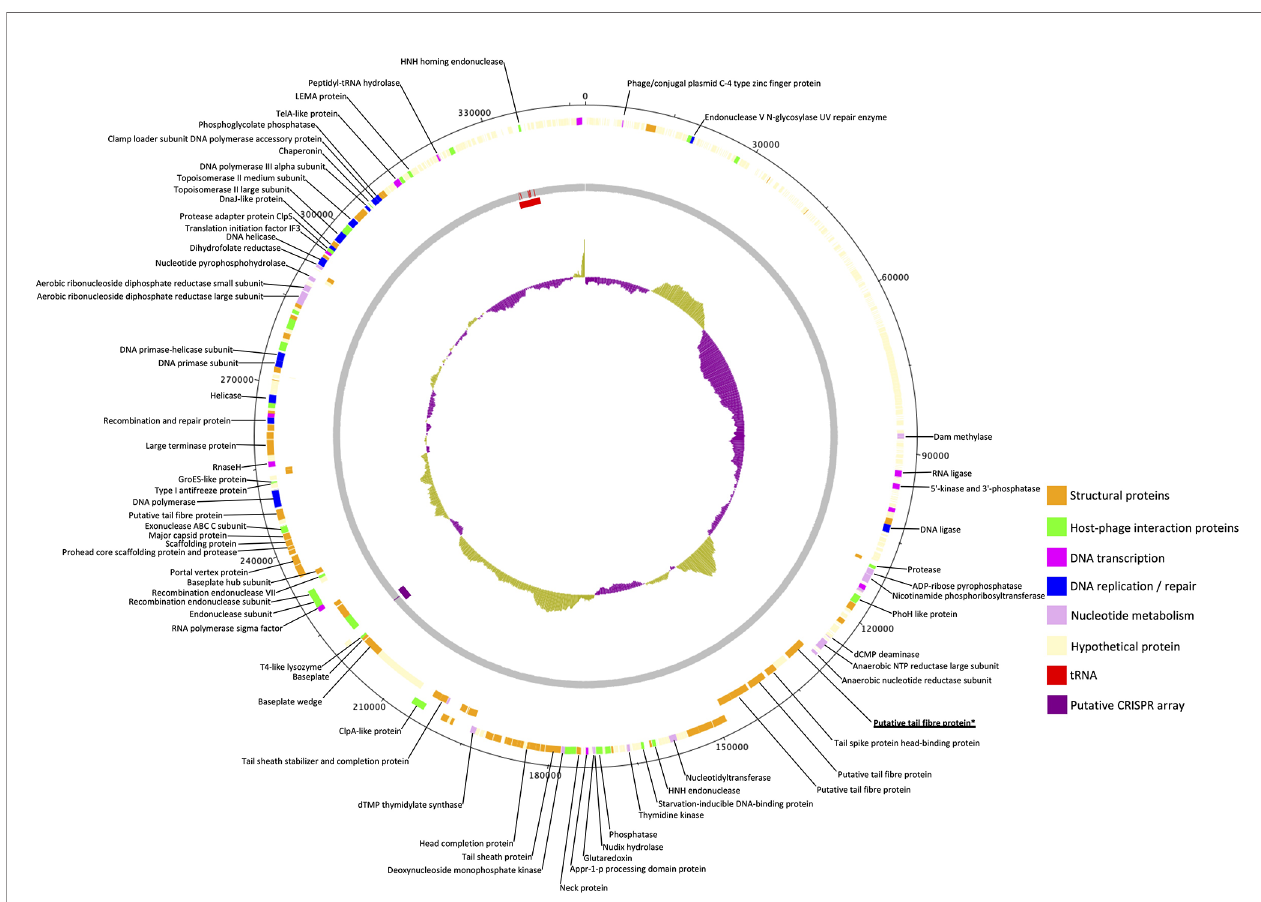
FIGURE 3 | Circular genomic map of Jumbo phage GBH019. Genes involved in virion structure (orange), host interaction (green), nucleotide metabolism (pink), DNA replication and repair (blue), and DNA transcription (magenta) are shown as the positions of six tRNAs (red) and a putative CRISPR array (purple). %GC is shown in the centre of the fi gure. Hypothetical proteins are shown in cream. Figure generated using DNA Plotter release